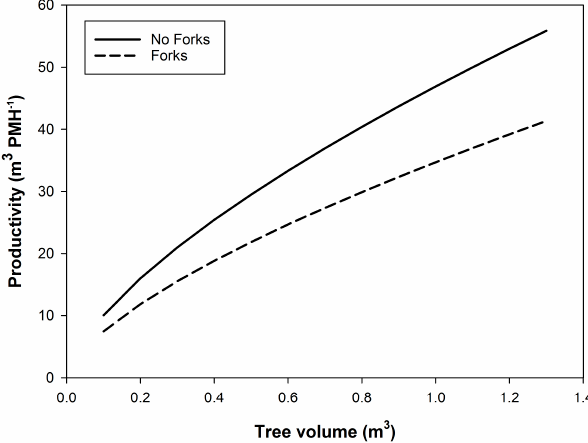
Figure 4. Harvesting productivity as a function of tree volume with and without forks. PMH is the productive machine hour excluding delays.